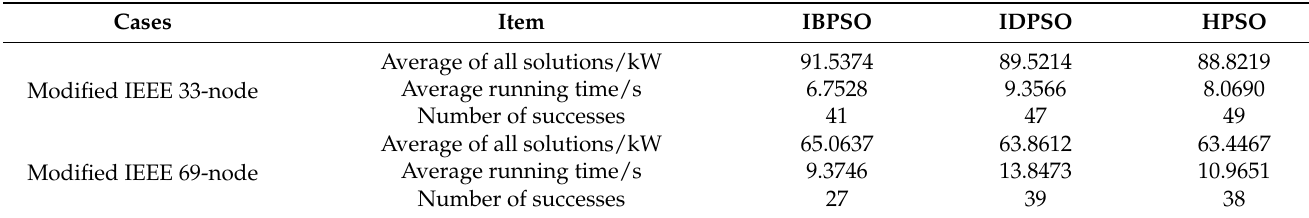
Table 3. Results of different algorithms.